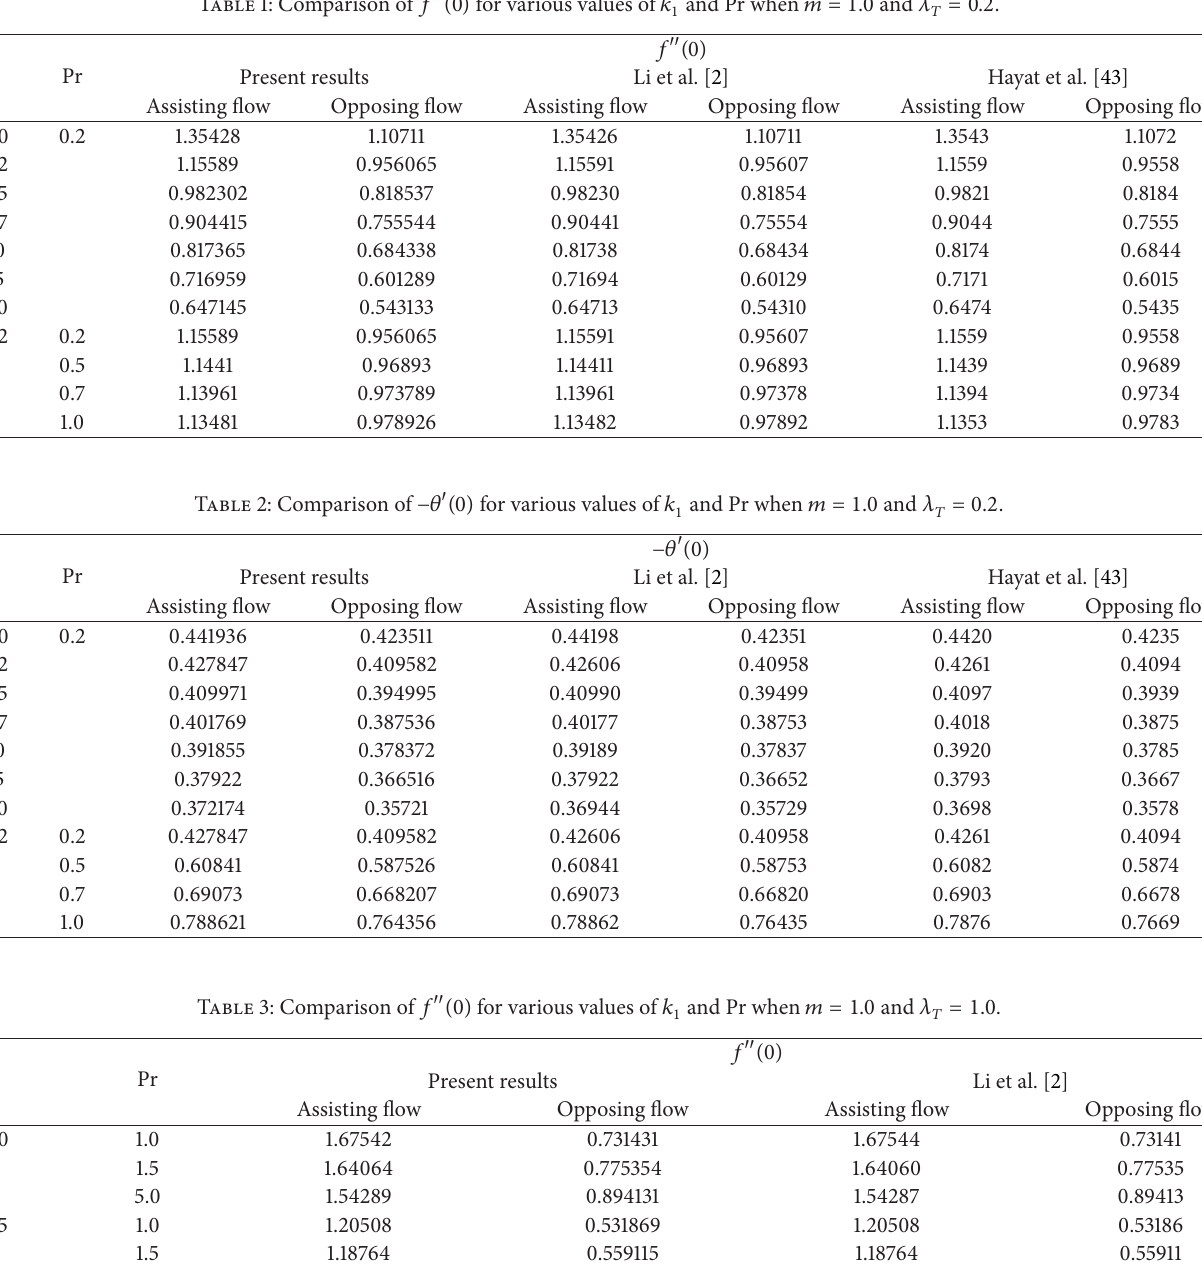
Table 1: Comparison of 𝑓 󸀠󸀠 (0) for various values of 𝑘 1 and Pr when 𝑚 = 1.0 and 𝜆 𝑇 = 0.2 .